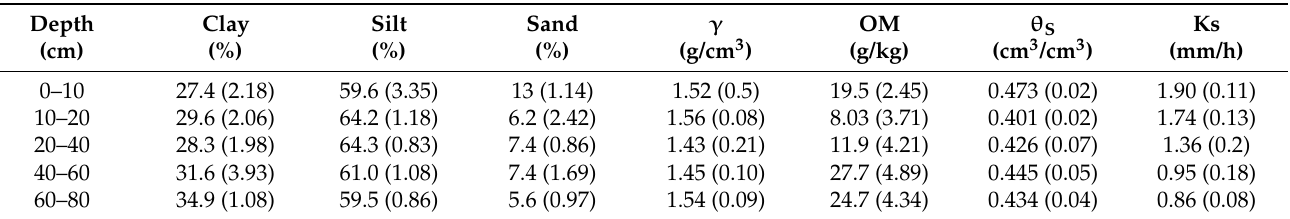
Table 1. Average and ± standard deviation of the physical and chemical properties and hydraulic parameters of BTQ